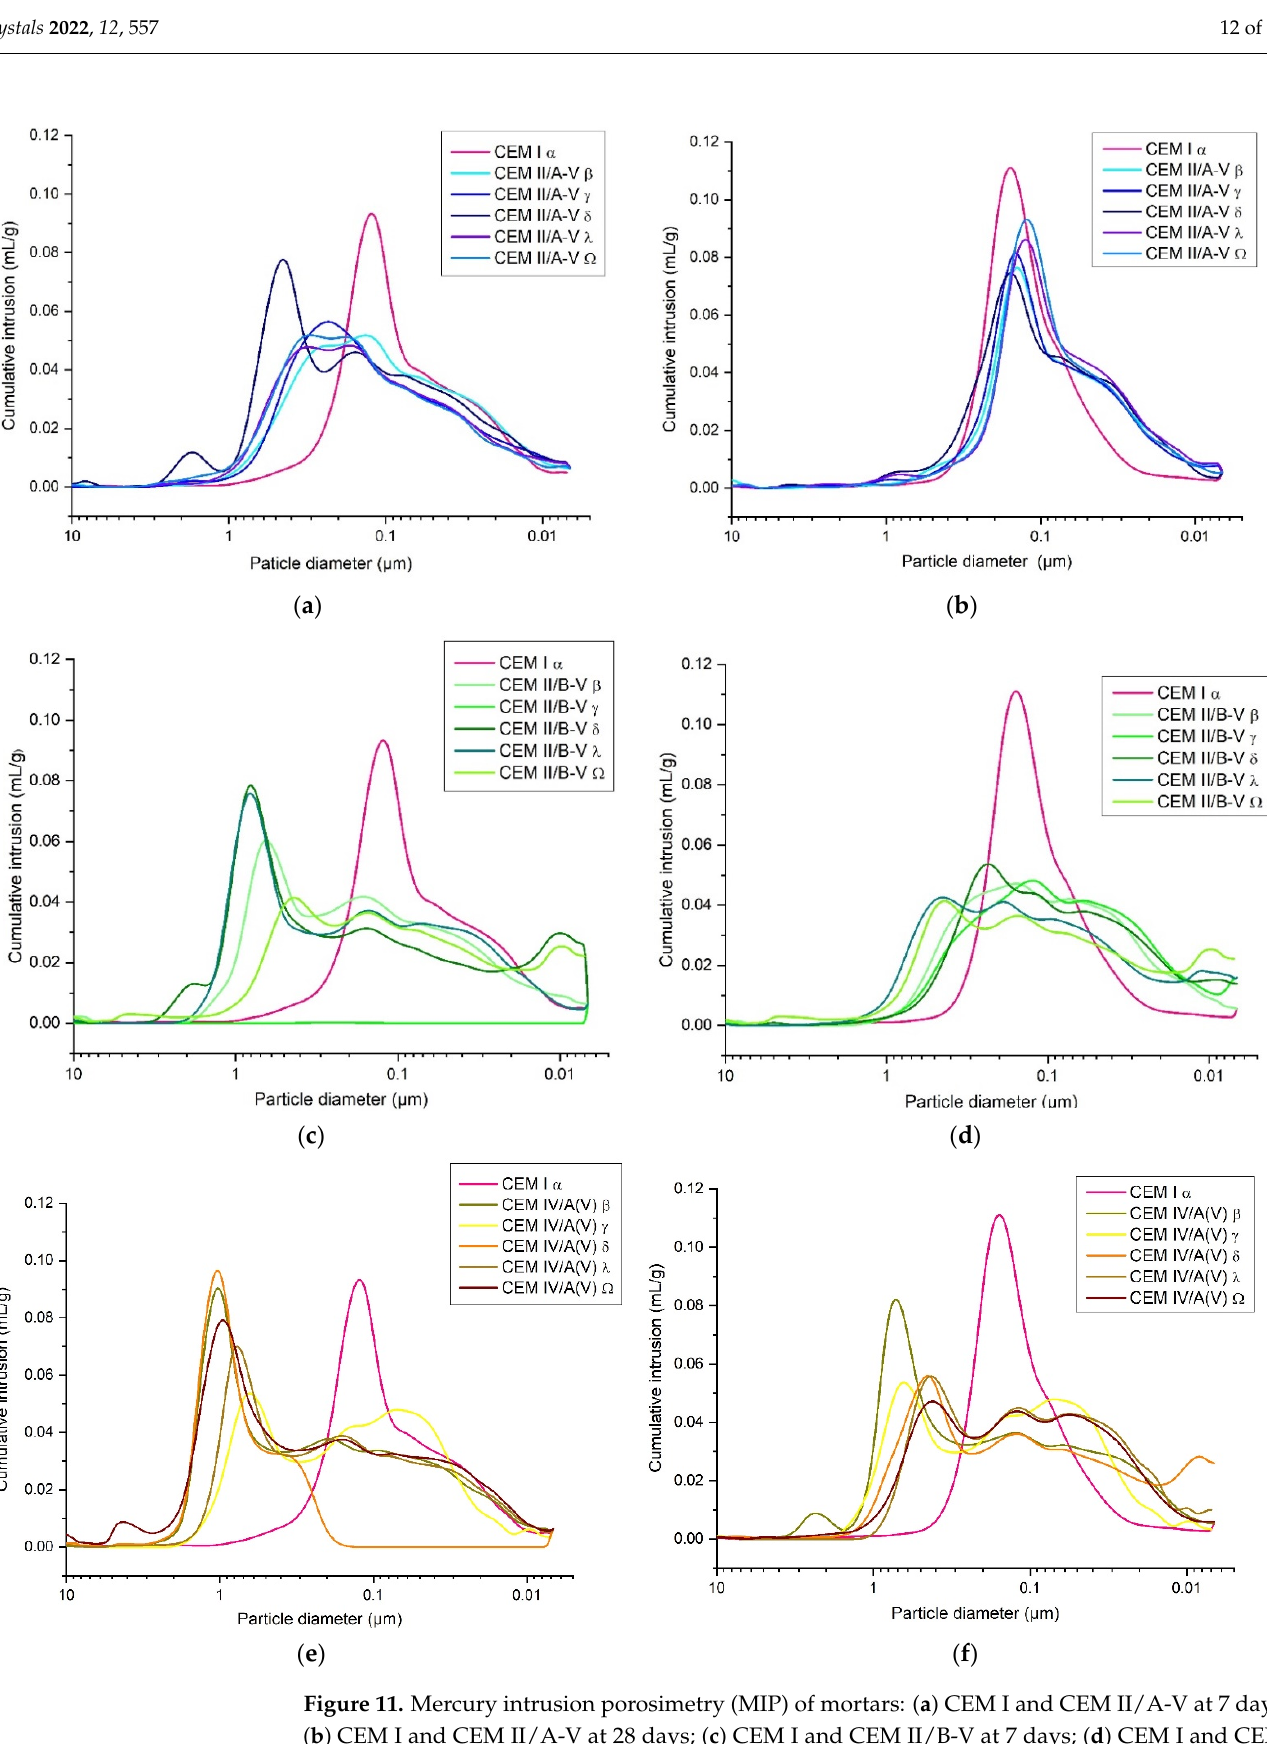
( b ) Figure 10. Calcium hydroxide content versus compressive strength at: ( a ) 28 days; ( b ) 90 days. Ca(OH) 2 content (%) = 3.7482 × Compressive strength (MPa) + 47.457, (1) The lack of correlation can be explained by the high capacity to fix calcium hydroxide at 28 days (Figure 9), but mortars do not harden significantly (Figure 8). For this reason, the coal ash mixes assessment requires the measurement of compressive strength devel- opment in the mortar, rather than determination of the content of fixed calcium hydrox- ide.